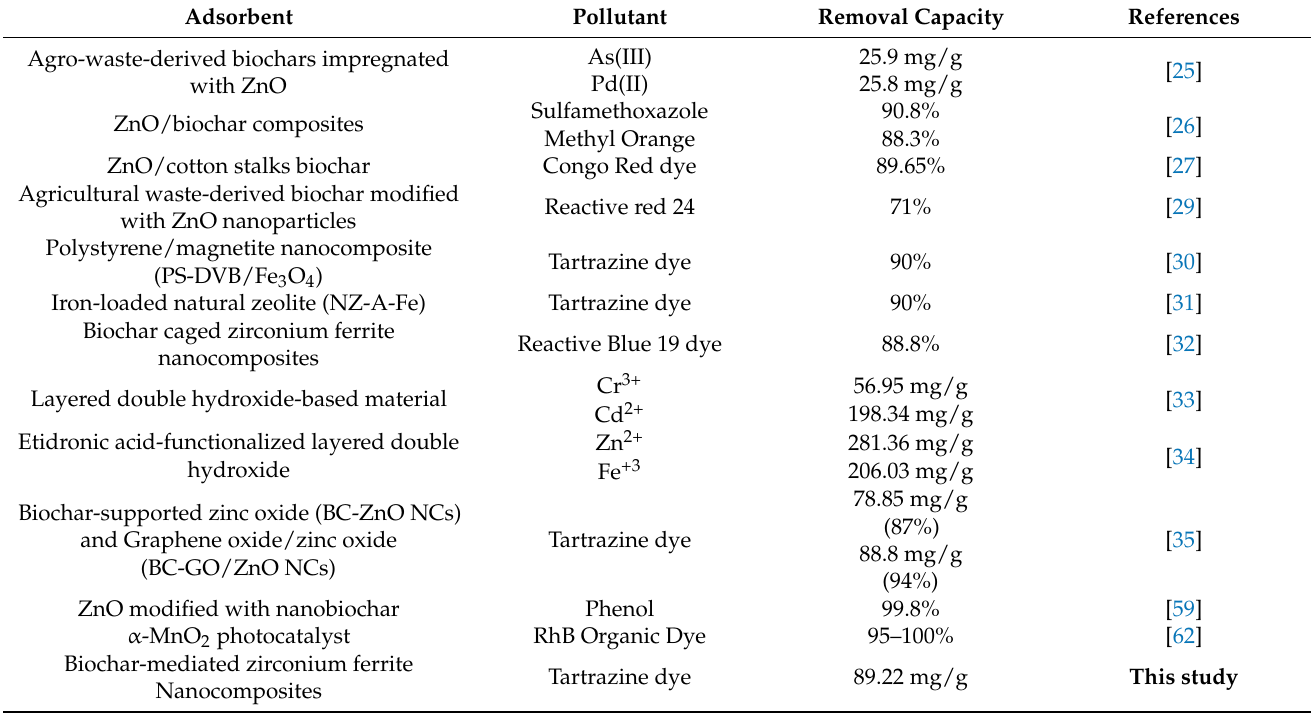
Figure 10. ( a ) Catalyst recyclability and ( b ) comparison among different catalysts (WSBM, WSBC and BC-ZrFe 2 O 5 NCs) for sorption of Tartrazine dye (at conditions 100 mg g − 1 dye concentration, 30 ◦ C temperature, 0.5 g sorbent dose). Table 1. Comparison of BC-ZrFe 2 O 5 NCs to previously reported nano-sorbents for different contami-